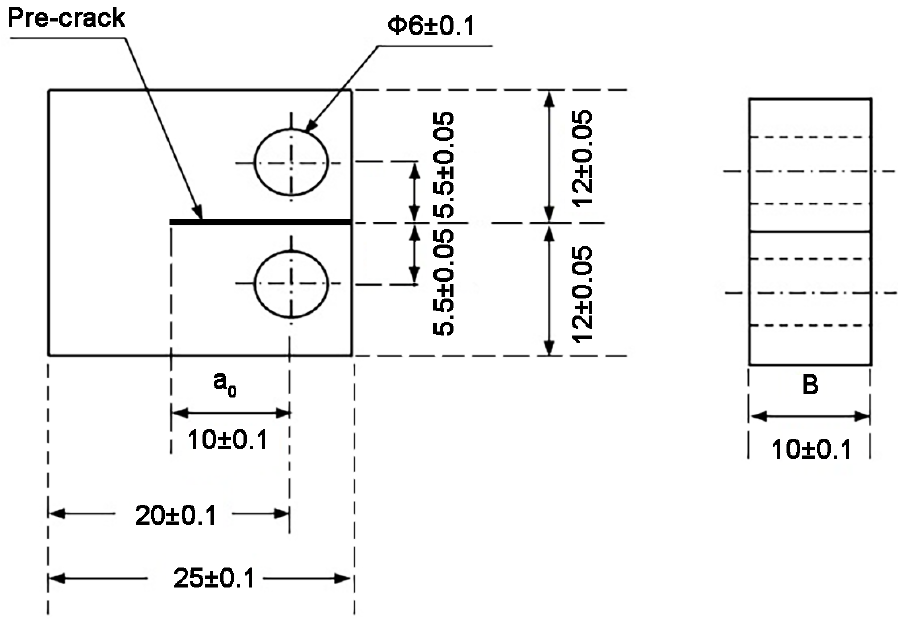
Figure 1. Compact tension specimen configuration used for crack growth tests, dimensions in mm.